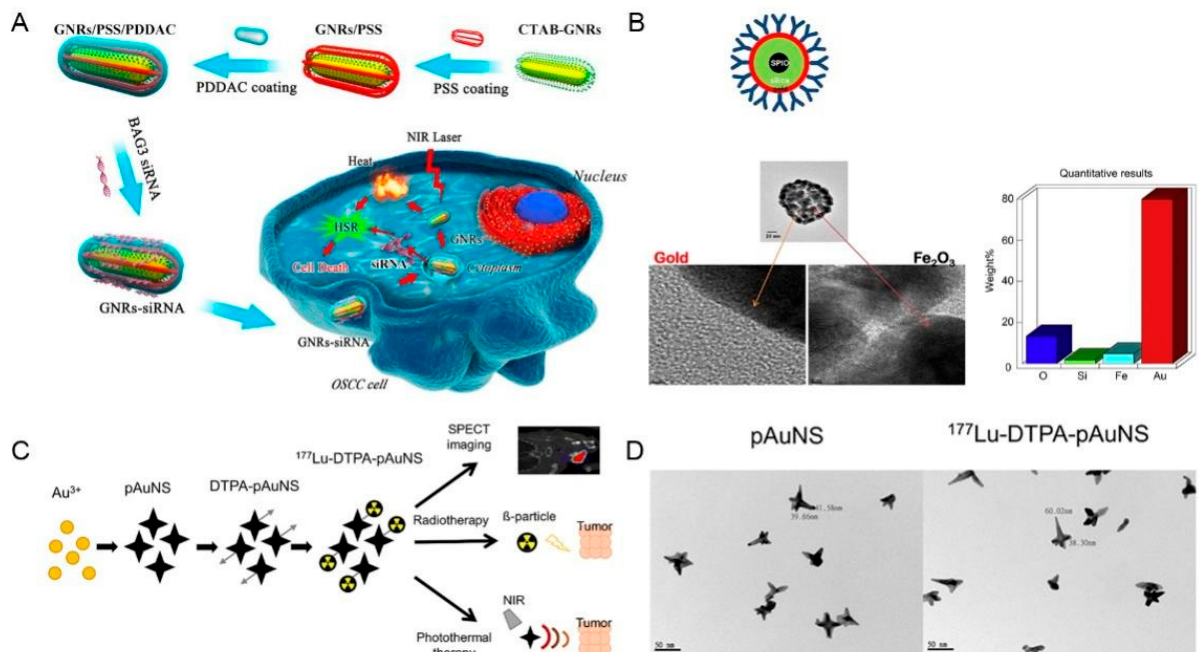
Figure 2. Schematic illustrations of several noble metal nanomaterials. ( A ) Schematic illustration of the design and application of gold-nanorods-small interfering RNA (GNRs-siRNA). ( B ) Structure illustration and high-resolution transmission electron microscopy (TEM) images of C225-ultrasmall paramagnetic iron oxide@Au nanoshell (C225-SPI@Au NS). ( C ) Schematic illustration of the prepa- ration and application of 177 Lu labeled PEGylated gold nanostars ( 177 Lu-DTPA-pAuNS). ( D ) TEM images of pAuNS and 177 Lu-DTPA-pAuNS. Adapted with permission from [39–41]. Copyright 2022, Elsevier, Elsevier and Multidisciplinary Digital Publishing Institute, respectively. PSS: polystyrene sulfonate; PDDAC: polydiallyl dimethyl ammonium chloride; CTAB: Cetyltrimethylammonium Bromide; NIR: near-infrared; OSCC: Oral squamous cell carcinoma; DTPA: Diethylenetriamine pentaacetate; SPECT: single-photon emission computerized tomography; PEG: polyethylene glycol.